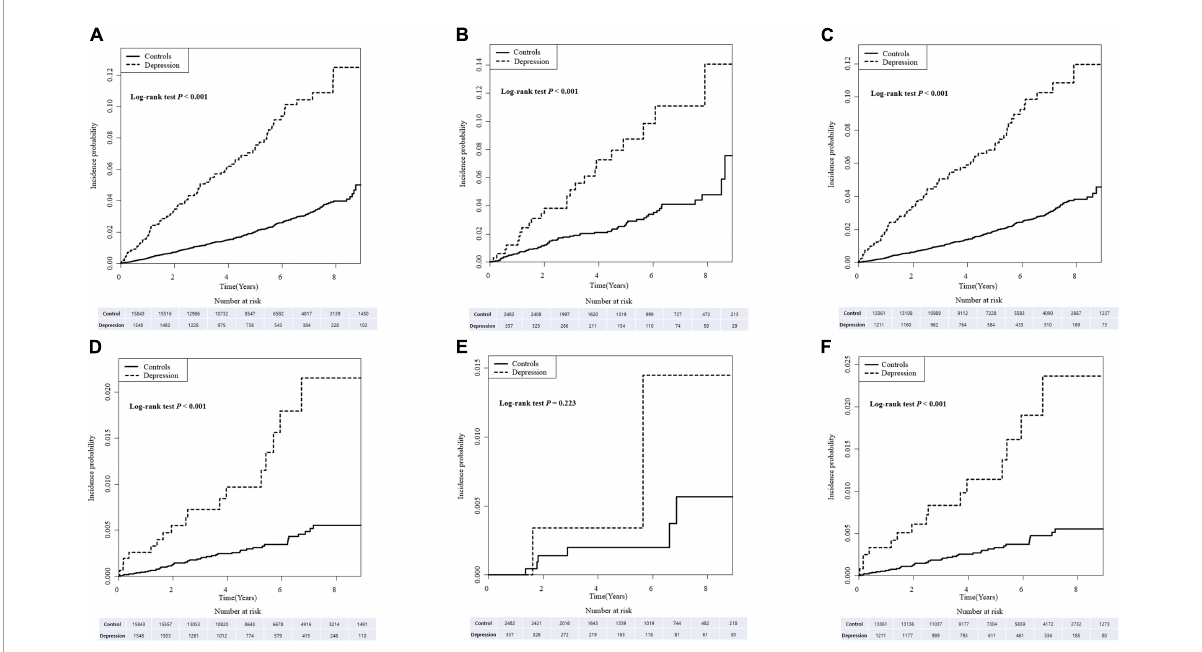
FIGURE1 The cumulative incidence of dementia (A–C) and Parkinson’s disease (PD) (D–F) in inflammatory bowel disease (IBD), Crohn’s disease (CD), and ulcerative colitis (UC) patients with depression compared with those without